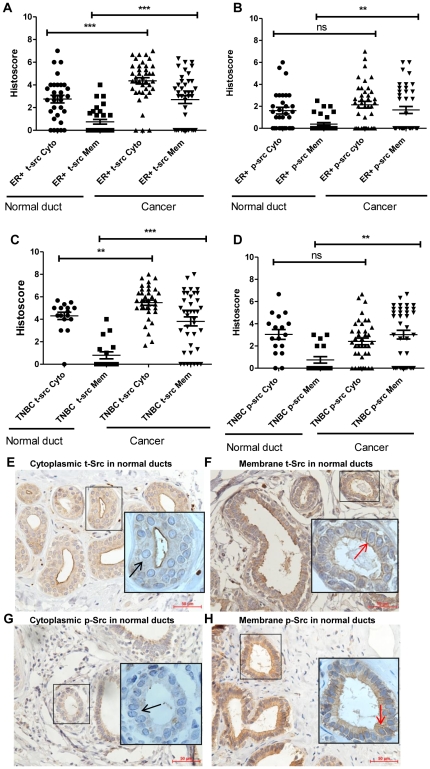
Src expression in breast cancer tissue and adjacent normal ducts of ER+BC and TNBC.A) Comparison between total Src (t-Src) subcellular localization in cytoplasm (Cyto) and membrane (Mem) of normal ducts and cancer of ER+BC; B) Comparison between p-Y416Src (p-Src) expression in cytoplasm and membrane of normal ducts and cancer of ER+BC; C) Comparison between total Src expression in cytoplasm and membrane of normal ducts and cancer of TNBC; D) Comparison between p-Src expression in cytoplasm and membrane of normal ducts and cancer in TNBC. Statistical difference in the distribution of total and p-Y416Src kinase in normal ducts and cancer was analyzed by the Mann-Whitney U test, * P<0.05, **P<0.01, *** P<0.001. All error bars represent the SEM (standard error of mean). E) A representative photomicrograph from a TNBC case showing a weak cytoplasmic (1+) t-Src staining in normal ducts as indicated by a black arrow. F) A representative photomicrograph from a TNBC case showing a weak membrane (1+) t-Src staining in normal ducts as indicated by a red arrow (original magnification ×200). G) A representative photomicrograph from a TNBC case showing a weak cytoplasmic p-Src staining (1+) in normal ducts as indicated by a black arrow. F) A representative photomicrograph from a TNBC case showing a weak membrane (1+) p-Src staining in normal ducts as indicated by a red arrow (original magnification ×200) Scale bar, 50 µm. Insets are magnified images from selected areas (small squares) to show the membrane and cytoplasmic Src staining clearly.